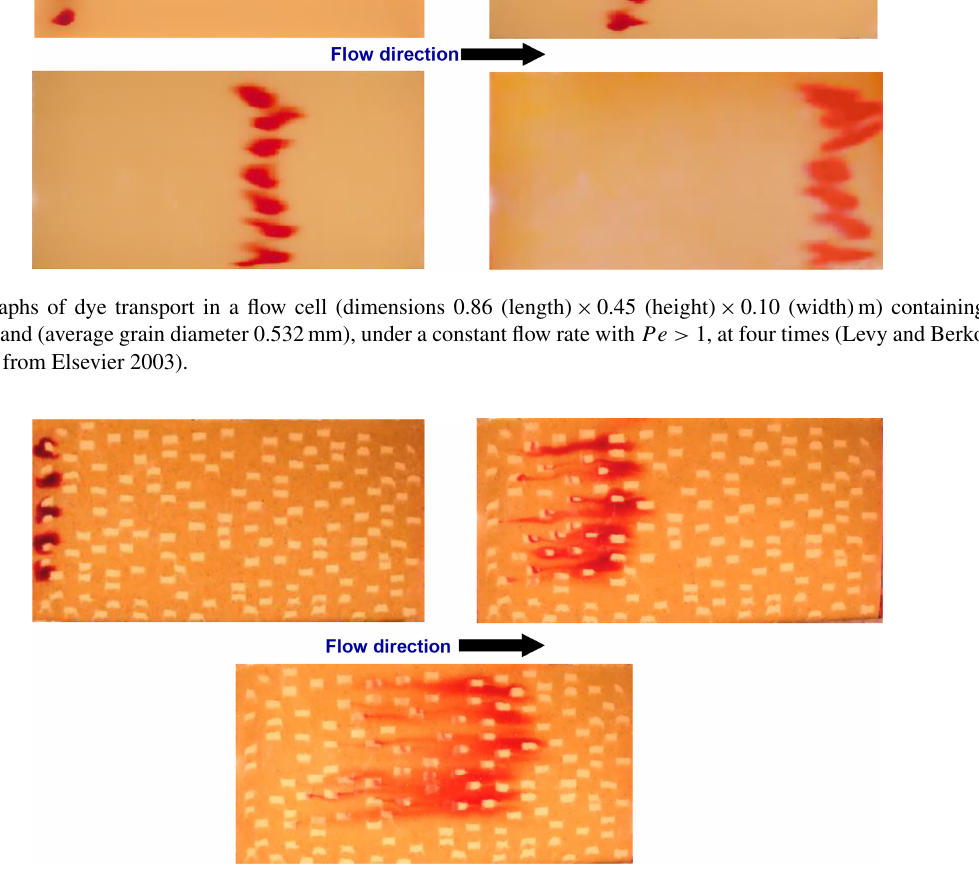
Figure 5. Photographs of dye transport in a flow cell (dimensions 0.86 (length) × 0.45 (height) × 0.10 (width)m) containing a randomly heterogeneous packing of quartz sand, under a constant flow rate with Pe > 1, at three times. The rectangular inclusions comprise sand with an average grain diameter ∼ 0 . 5 × smaller and hydraulic conductivity ∼ 3 × lower than the surrounding sand matrix (Levy and Berkowitz, 2003; © with permission from Elsevier